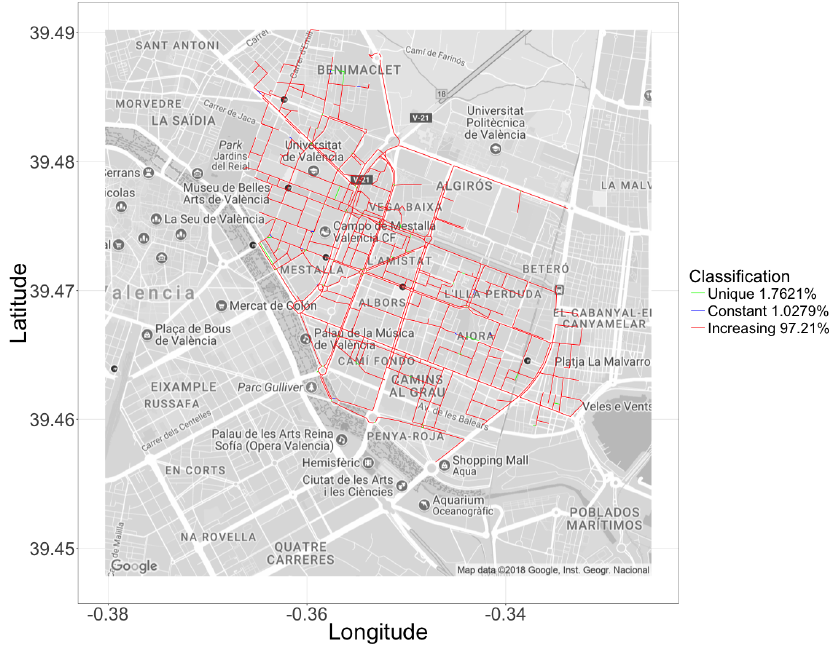
Figure 12. Geographical distribution of the segments in the different clusters for the hotspot